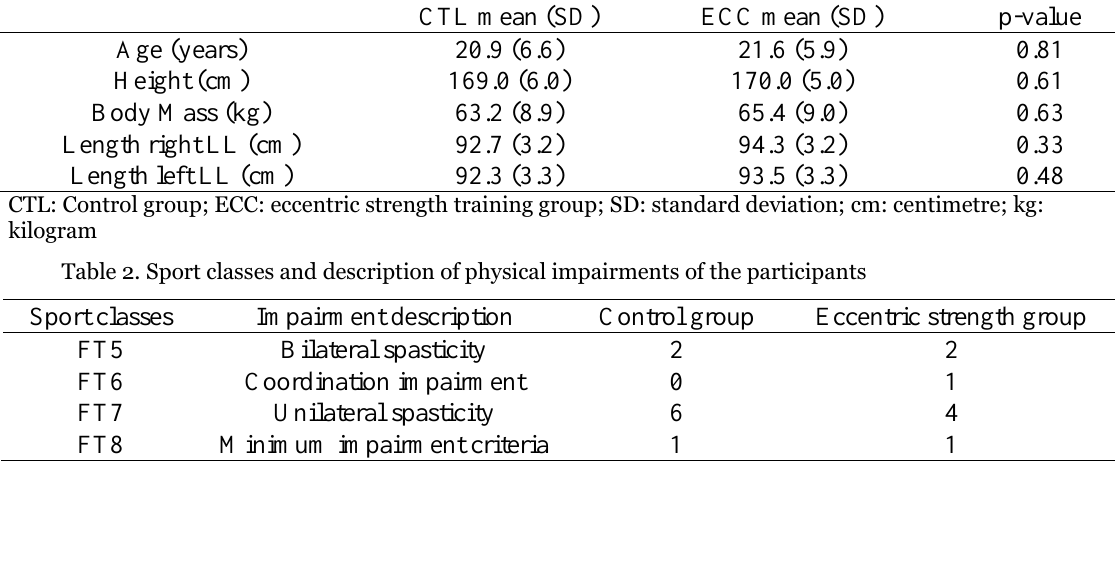
Table 1. Mean physical characteristics of the participants and Student’s t -test between groups.